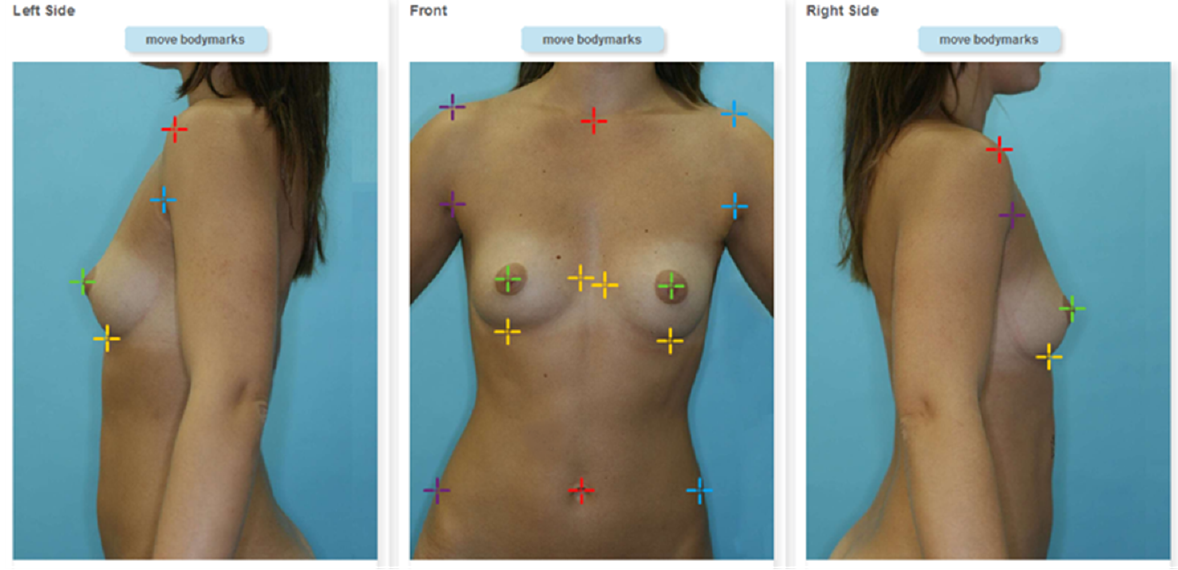
Figure 2. Three landmarked photos of a patient. Visual aids on where to place landmarks and a simple Web interface guide the user through the annotation of images. Cropped screenshot taken from the Web-based